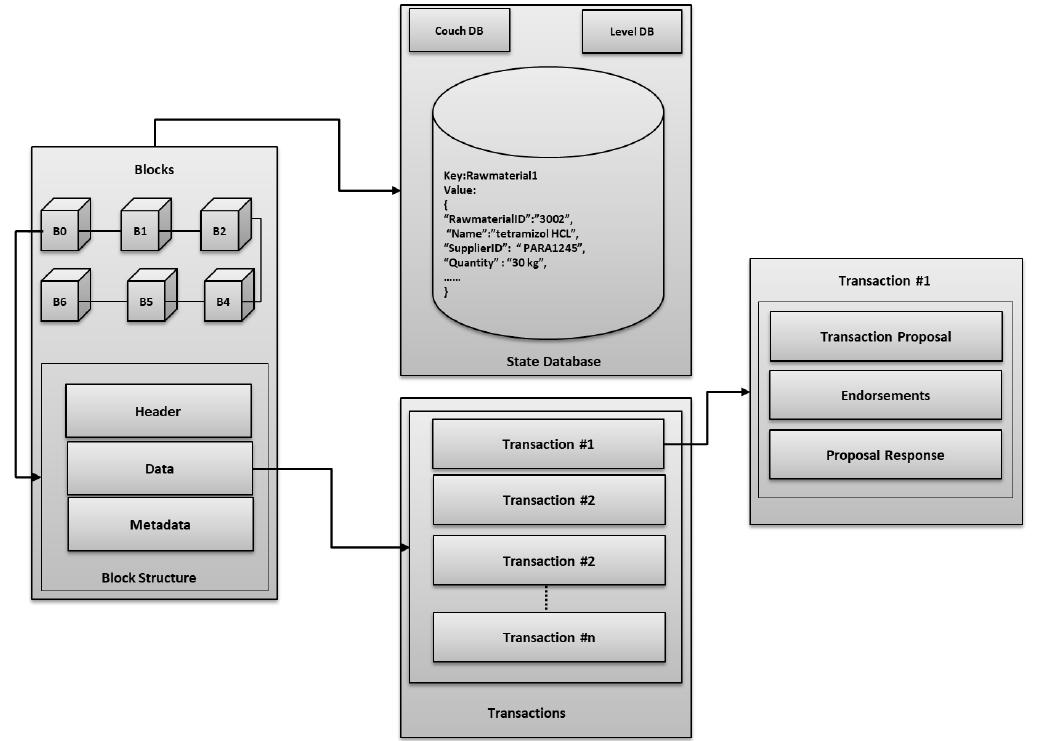
Figure 12. Blocks, transaction and ledger communication